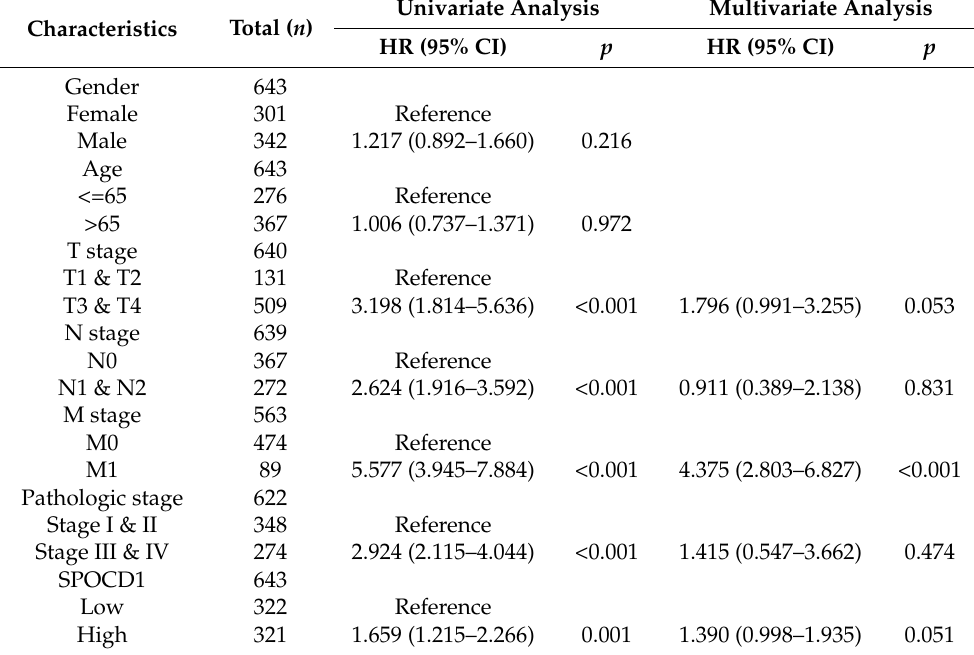
Table 4. The univariate and multivariate analysis of Progression Free Interval